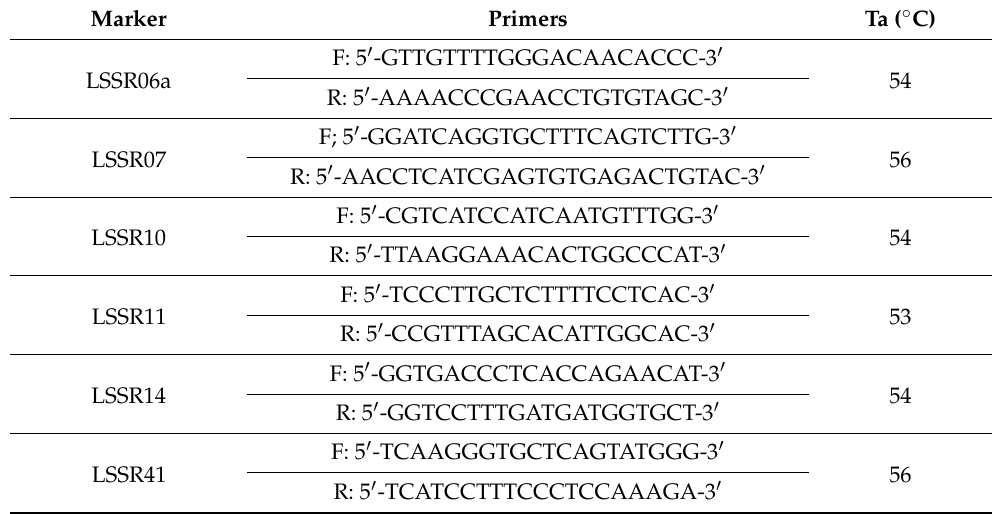
Table 3. Primer sequences and annealing temperature of the